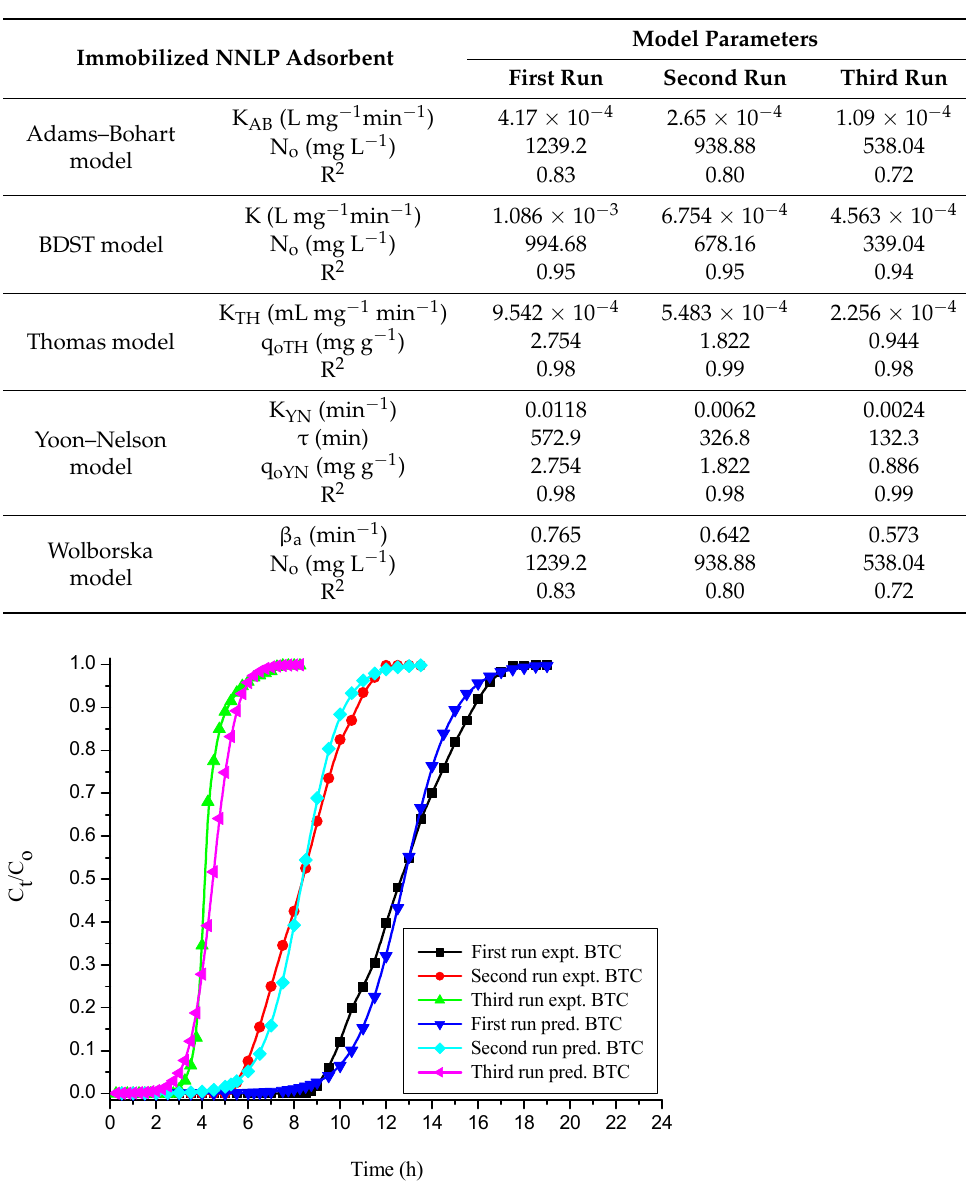
Model Parameters